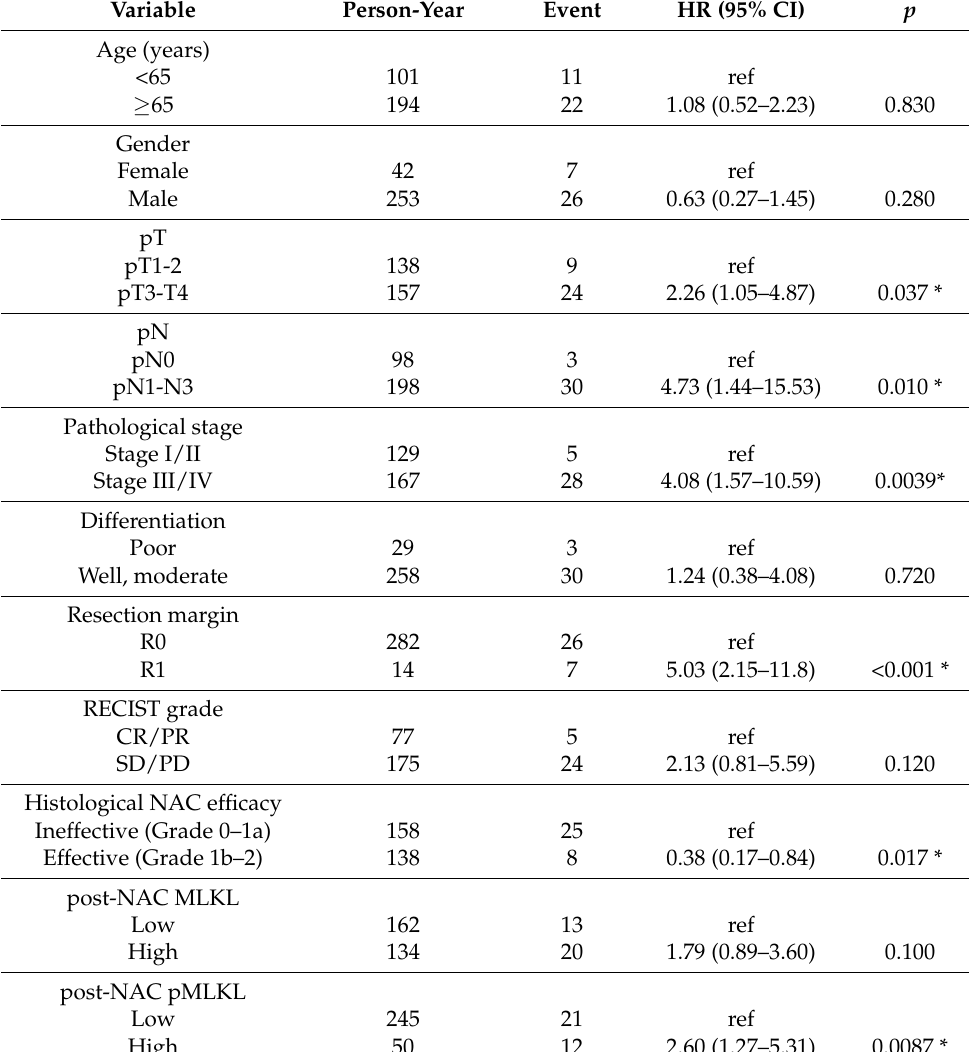
Table 2. Univariable analysis of patients’ 5 year overall survival.